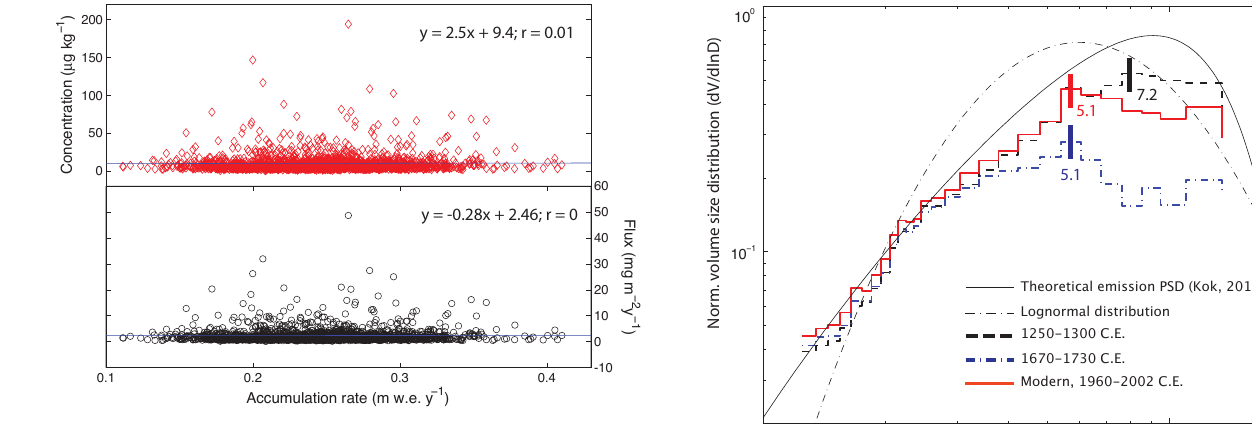
Figure 3. Dust concentration and flux plotted vs. accumulation rate; linear regressions are given.